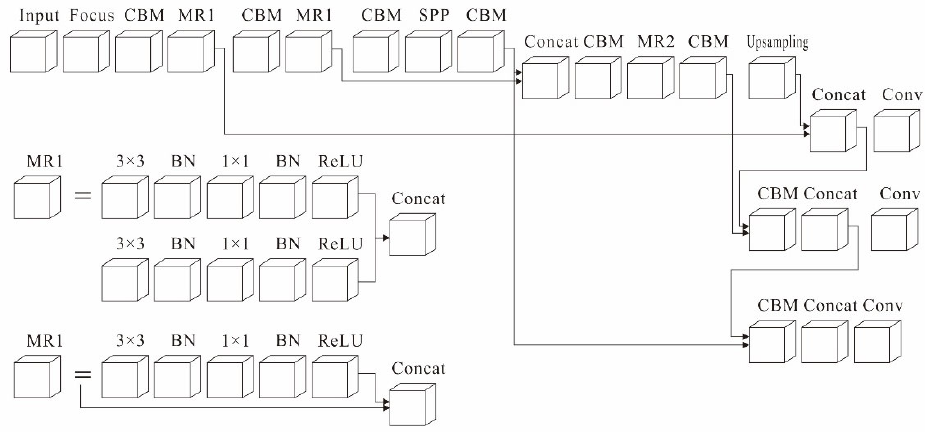
Figure 4. Structure of the proposed MC ‐ LCNN.